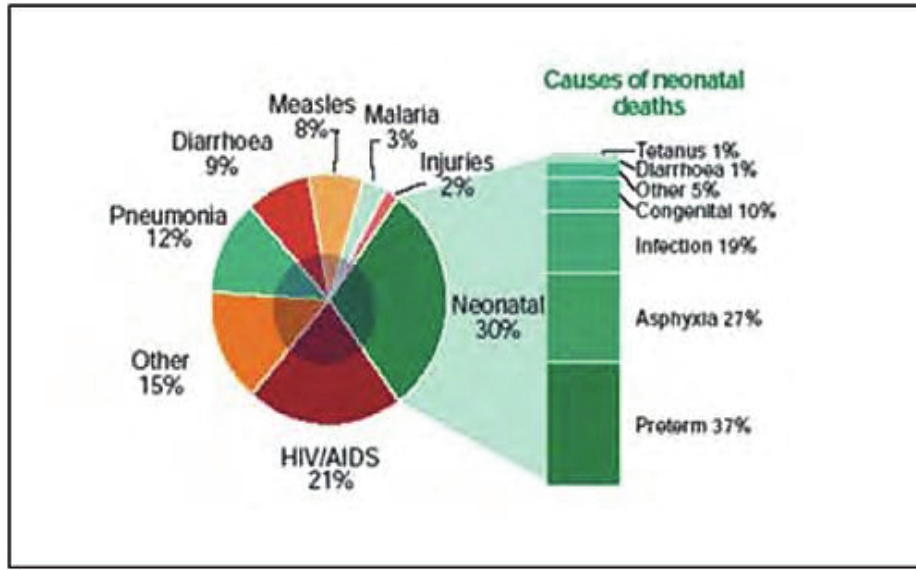
Figure 5: Causes of death in the under-five age group in Zimbabwe